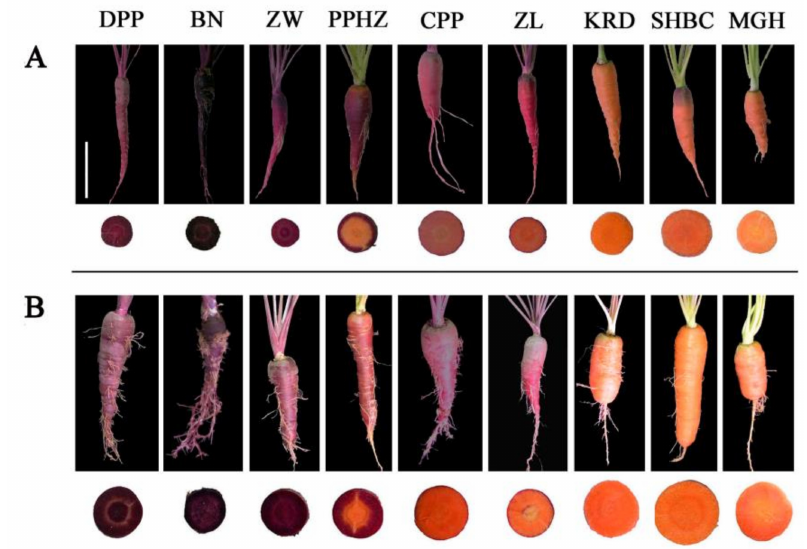
Figure 6. The color of cross-sections and the taproots of nine purple and non-purple carrots cultivars at two different stages. ( A ) represents the purple and nonpurple carrots grown for 70 days. ( B ) rep- resents the purple and nonpurple carrots grown for 110 days. Cultivar abbreviations: DPP, Deep purple; BN, Black nebula; ZW, Ziwei; PPHZ, Purple haze; CPP, Cosmic purple; ZL, Zilong; KRD, Kurodagosun; SHBC, Sanhongbacun; MGH, Meiguihong. White bar represents 5 cm.